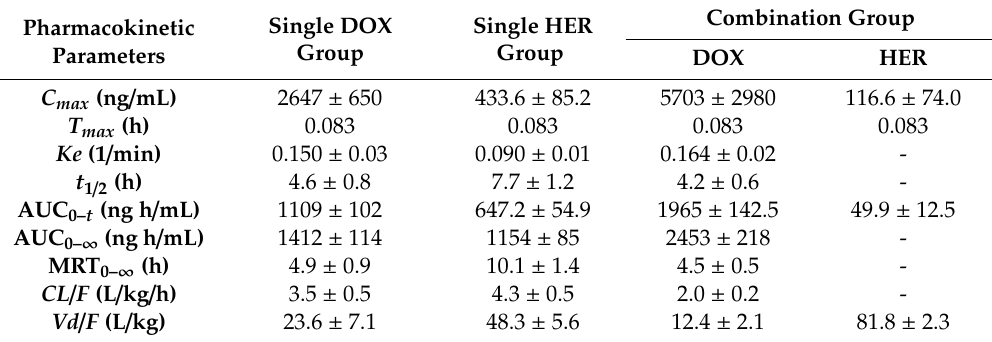
Figure 3. ( A ) Mean plasma concentration–time curves of doxorubicin in a single doxorubicin group and combination group; ( B ) Mean plasma concentration–time curves of hernandezine in a single hernandezine group and combination group. Table 5. Non-compartmental pharmacokinetic parameters of hernandezine and doxorubicin in a single doxorubicin group, single hernandezine group, and combination group (n =